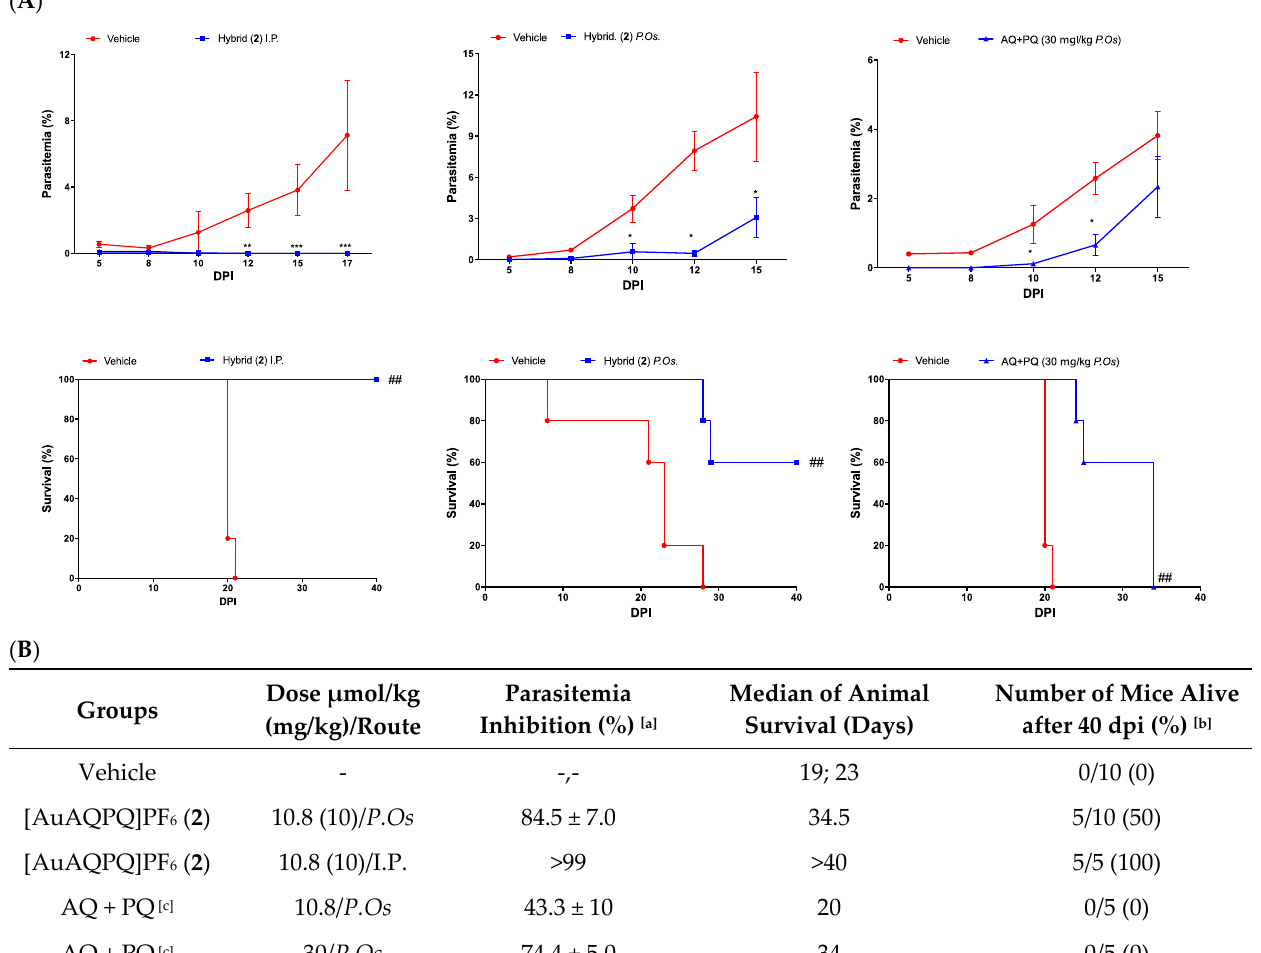
Figure 3. Efficacy of compounds to suppress the parasitemia in P. berghei -infected Swiss mice. Panel ( A ): Representative graphs of parasitemia and animal survival. Panel ( B ): Table summarizing the results. Footnotes for table: [a,b] Values are from a single experiment, using n = 5/group unless indicated. [a] Values are mean and standard deviation determined in comparison to vehicle group. [c]